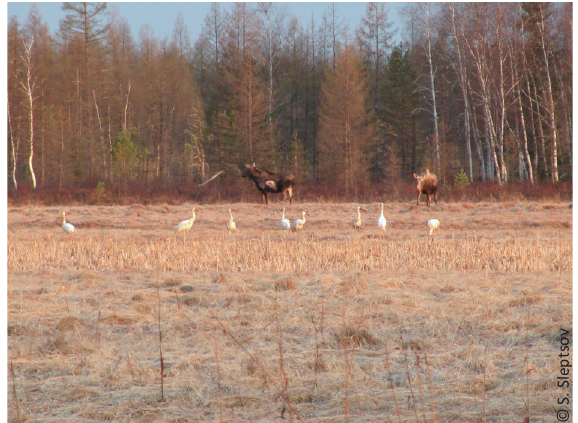
Image 2. Siberian Cranes in salt